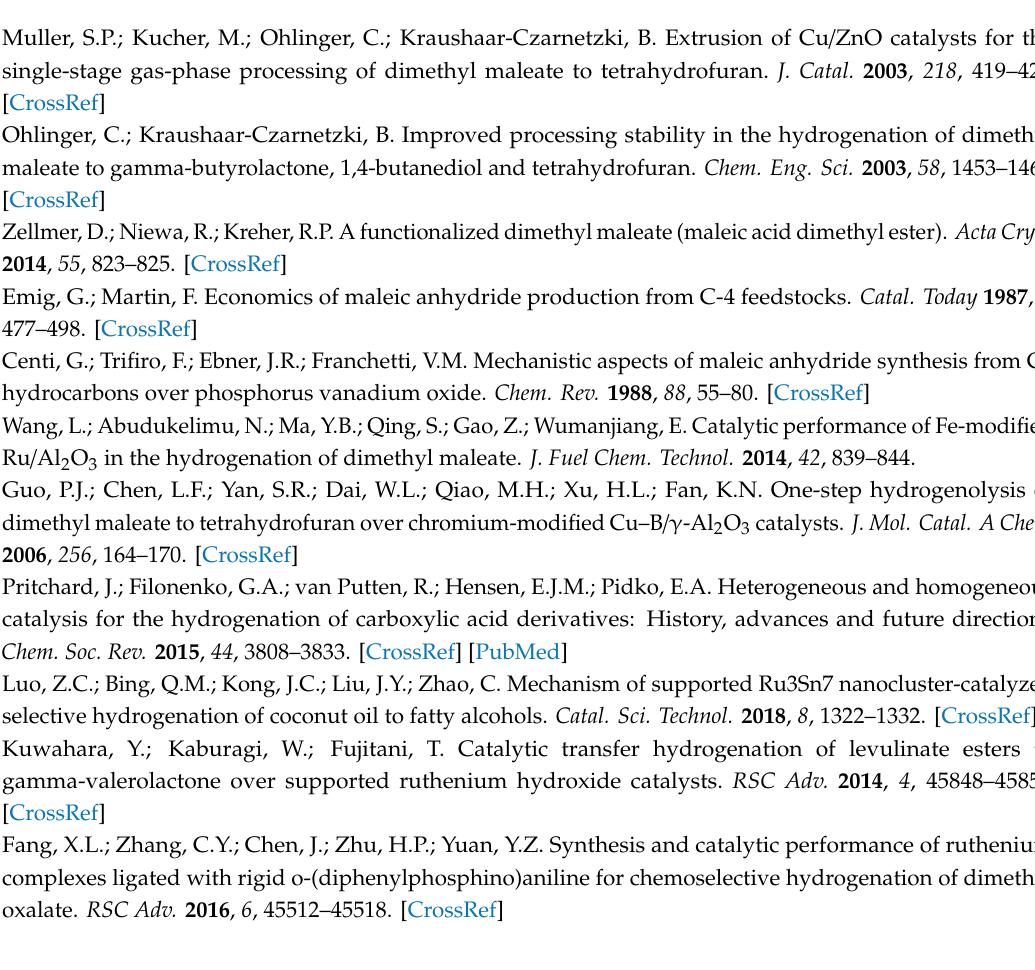
Figure S1: X-ray di ff raction patterns of the calcined catalysts: (a) Cu / SiO 2 ; (b) Cu-Mg / SiO 2 ; (c) Cu-Ca / SiO 2 ; (d) Cu-Sr / SiO 2 ; (e) Cu-Ba / SiO 2 ; (f) Cu-La / SiO 2